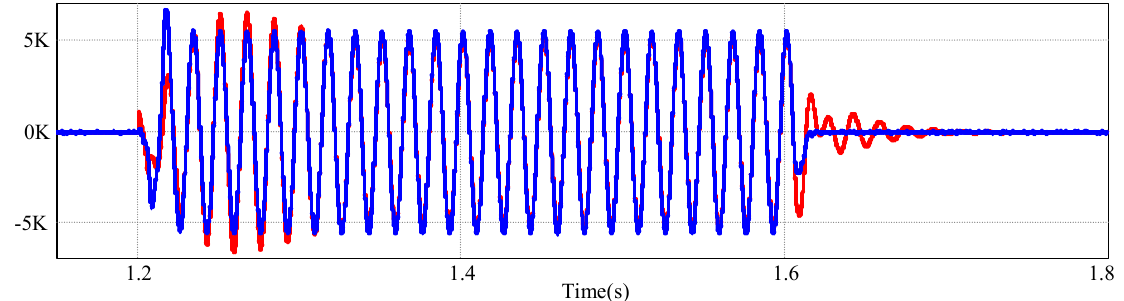
Figure 6. Comparison of the zero-sequence voltage of the leg balancing feedback controller without the feedforward term and the calculated feedforward term from the proposed method under unbalanced load conditions.